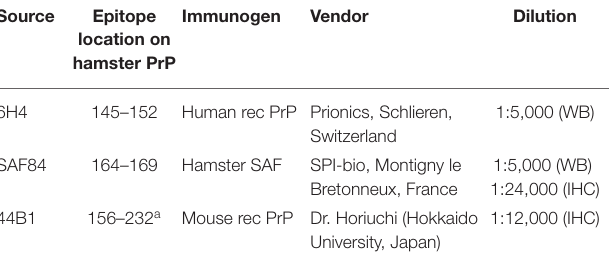
TABLE 1 | Monoclonal anti-PrP antibodies used in this